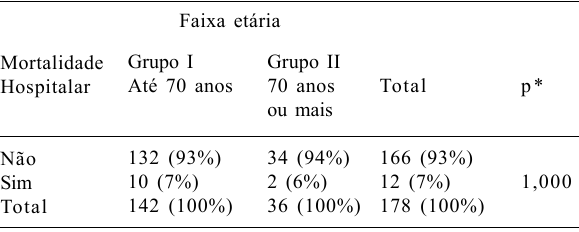
Tabela 4. Porcentual de óbito por faixa etária restrita às operações incluindo arterial radial como 2º enxerto